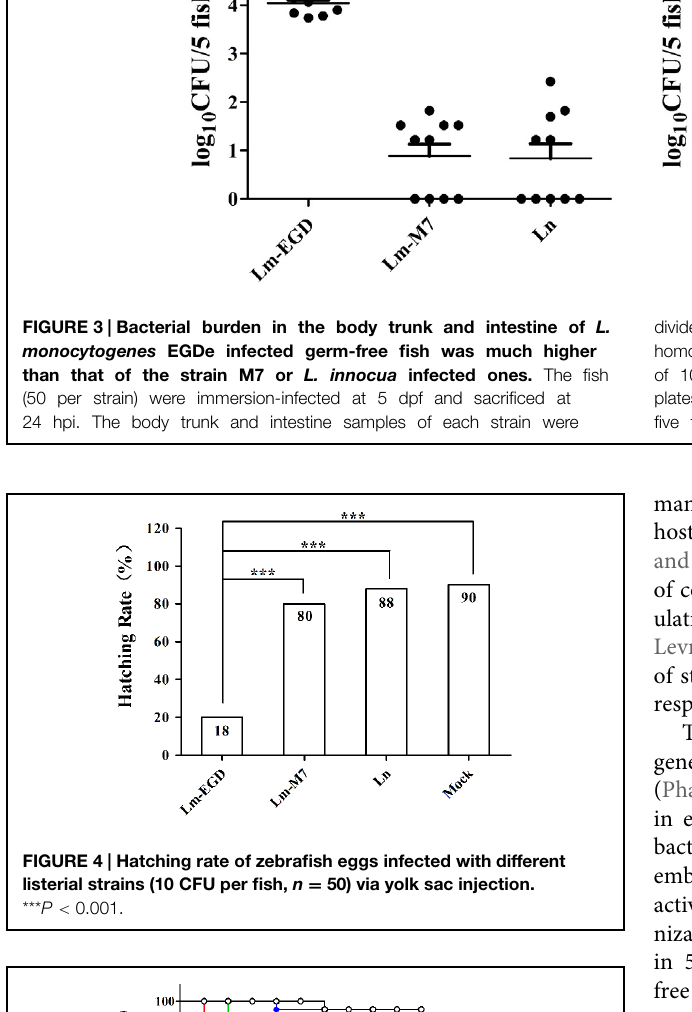
FIGURE 4 | Hatching rate of zebrafish eggs infected with different listerial strains (10 CFU per fish, n = 50) via yolk sac injection. *** P < 0.001.